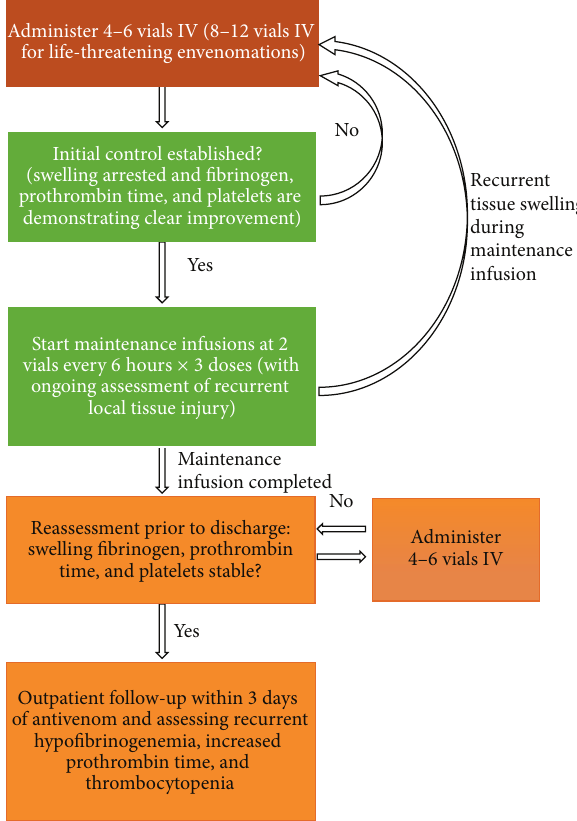
Figure 1: Flowchart of treatment of snake bite by Goldfrank’s Toxicologic Emergencies textbook [6].